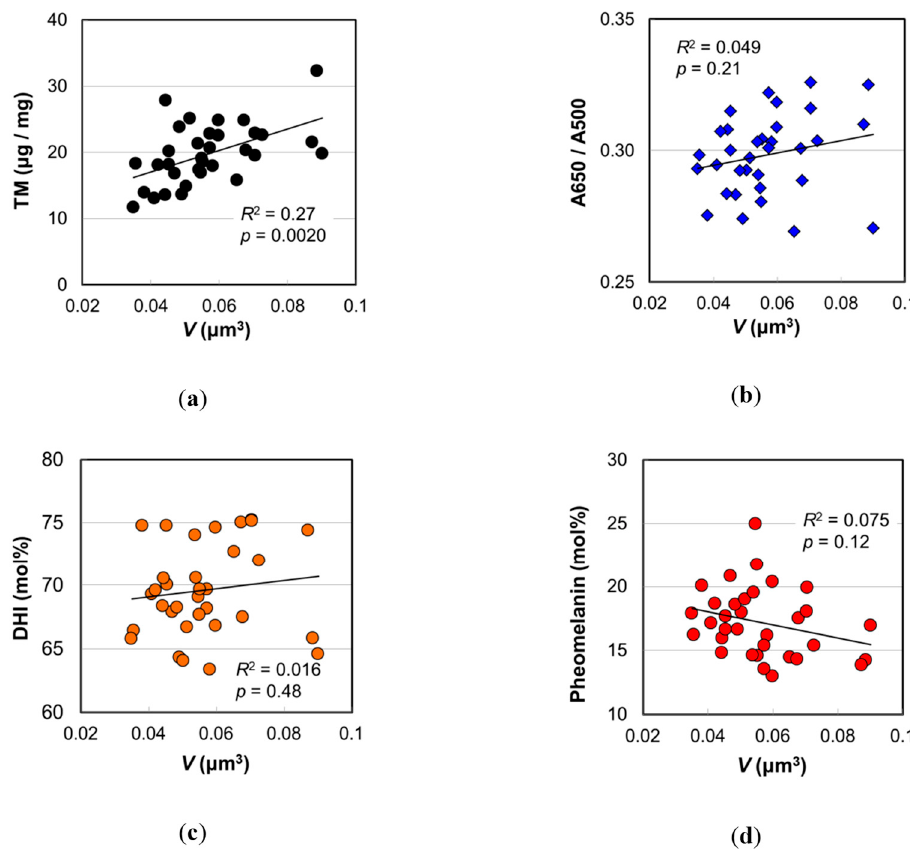
Figure 5. Various values measured by hair melanin analyses vs. mean volume of melanosomes isolated from Japanese female hair samples with an assumption of ellipsoid. ( a ) Total melanin amount. ( b ) Absorbance ratio A650/A500. ( c ) DHI mol%. ( d ) Pheomelanin mol%. The coefficient of determination and the p -value are shown in each figure.